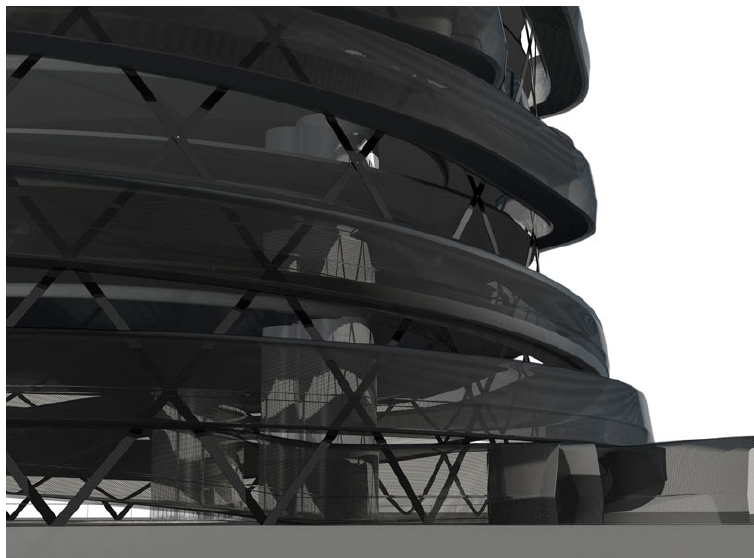
Figure 8. Testa and Weiser, Carbon Tower. In-house rendering of the tower base testing lighting technique, 2002. Part of AP174.S1.2001.D1.010, 189.891 KB, last modified 15 December 2002. Gift of and © Testa and Weiser.